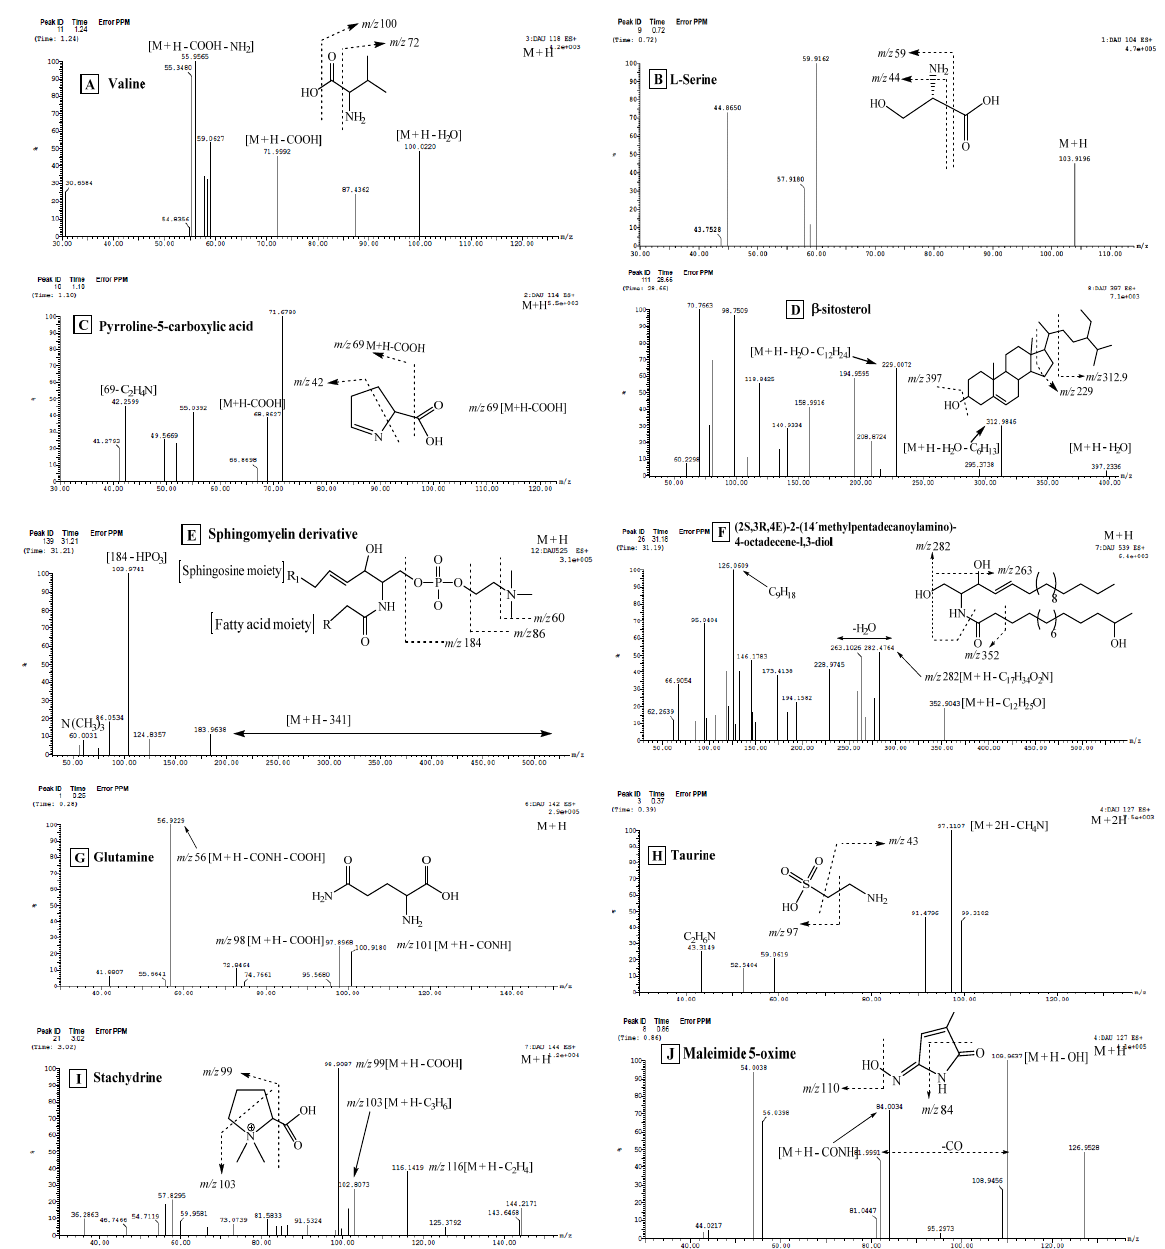
Figure 4. UPLC-ESI-MS/MS chromatograms of some identified compounds from Cliona sp. in positive (+) ionization mode: ( A ) Valine; ( B ) L -Serine; ( C ) Pyrroline-5-carboxylic acid; ( D ) β -sitosterol; ( E ) sphingomyelin derivative; ( F ) (2 S ,3 R , 4 E )-2-(14 ′ -methyl-pentadecanoylamino)-4-octadecene-l,3- diol; ( G ) Glutamine; ( H ) Taurine; ( I ) Stachydrine; ( J ) Maleimide 5-oxime.